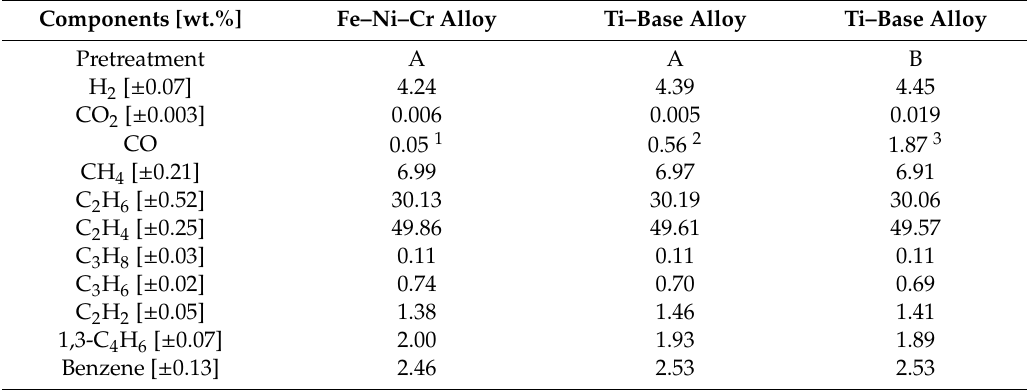
Table 3. Averaged (over the eight cracking cycles) mass product yields. Components